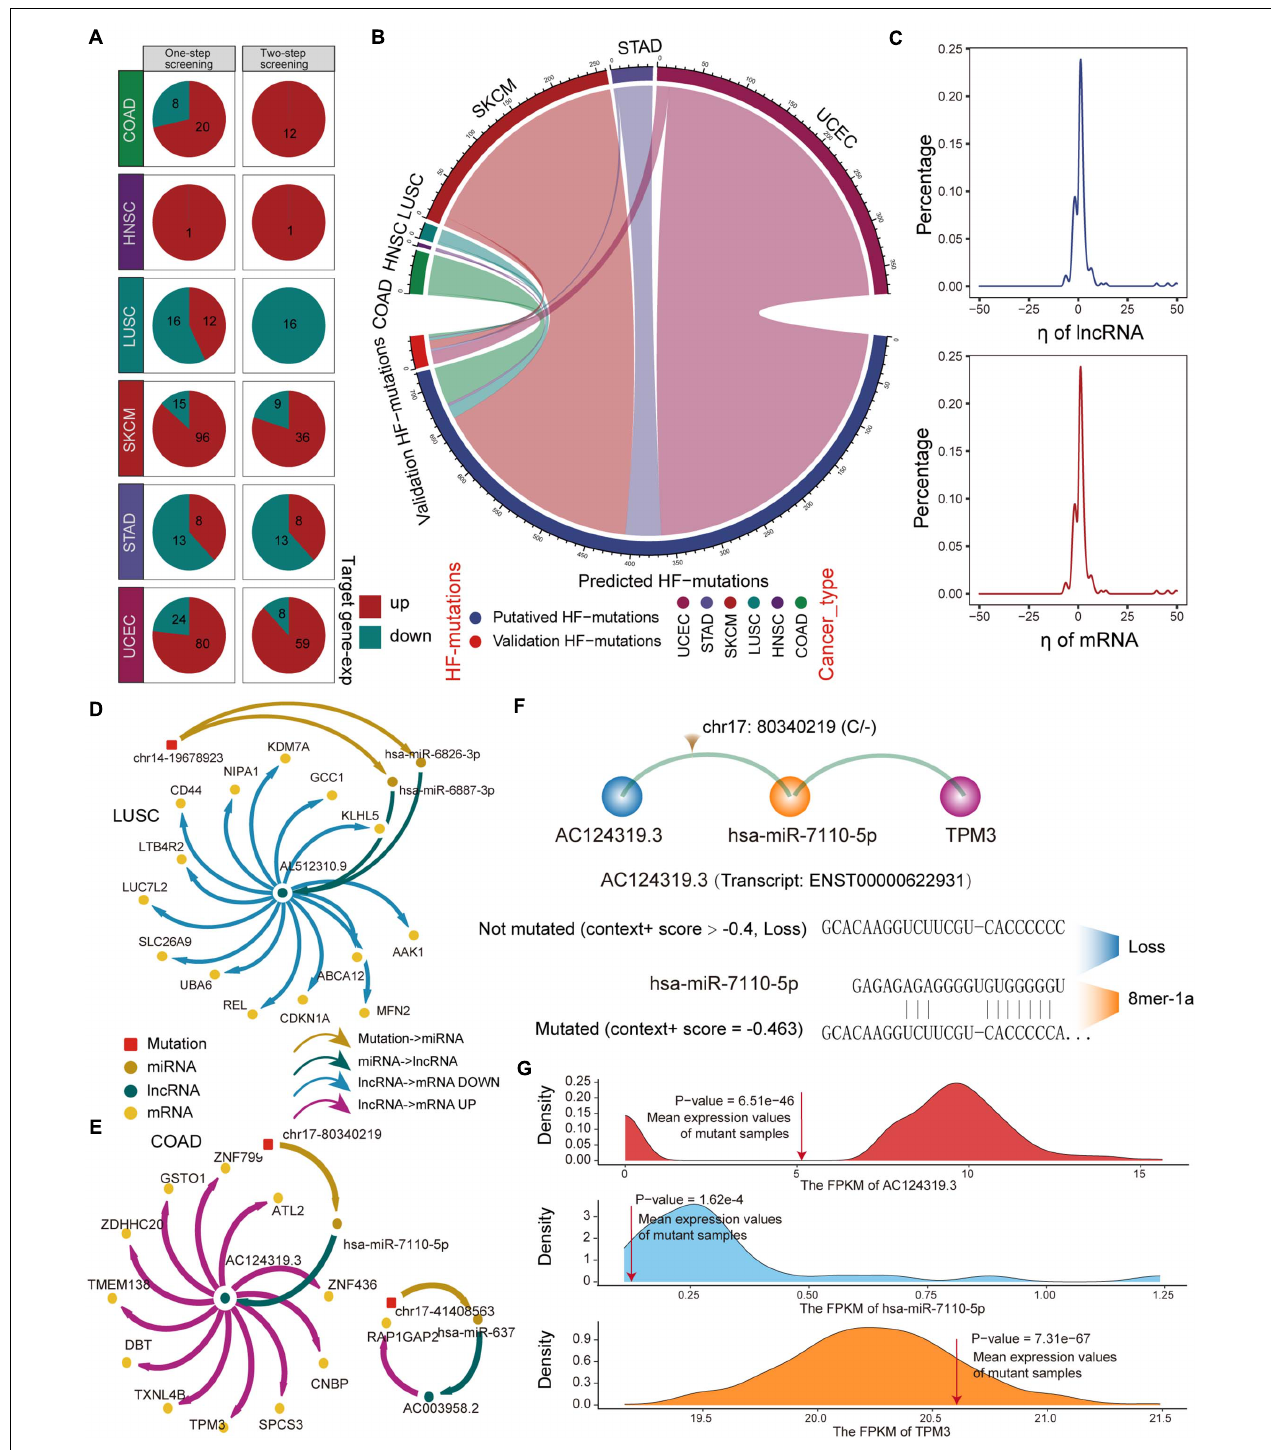
FIGURE 3 | Regression model to identify HF-SMILM units. (A) HF-SMILM units that passed one-step and two-step screening in six cancer types. Directions of change in the expression of ceM in the HF-SMILM unit affected by the mutation are marked by blue and red. (B) Circle diagram of proportions of putative mutations in these six cancers before and after the regression test. (C) Distribution of regression coefficients of ceL and ceM in the multiple regression analysis of the HF-SMILM units. (D) Regulatory network of HF-SMILM units that passed regression test in LUSC. Unique identifiers used by nodes and interactions in the network. (E) Same as in (D) but for HF-SMILM units that passed regression test in COAD. (F) Binding affinity changes of AC124319.3 and hsa-miR-7110-5p before and after the chr17: 80340219 (C/–) mutation in AC124319.3. (G) The density curve reflects the distribution of genes expression for COAD and the average expression level of the genes in the mutant sample was marked with a red line. The one-sample t -test was used to calculate statistical significance.